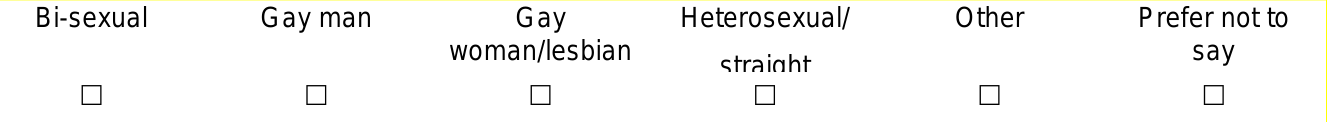
Cervical Cancer Awareness Measure Toolkit Version